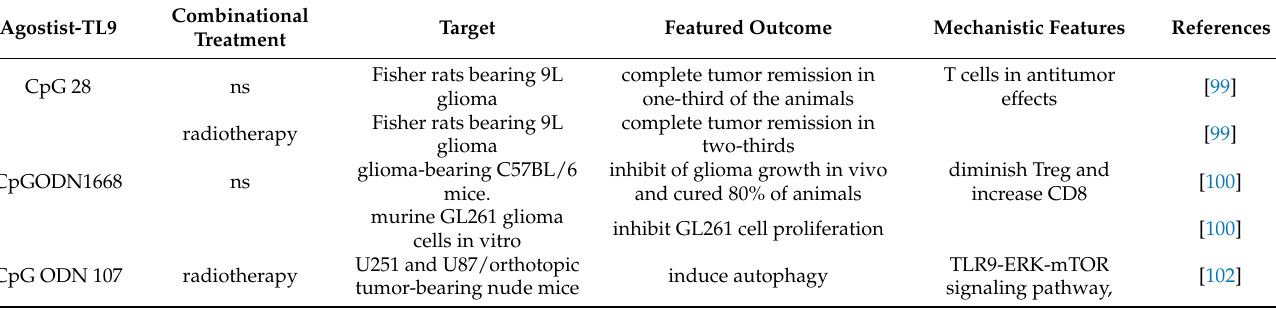
Table 1. TLR9 antitumoral based treatment upon stimulation with